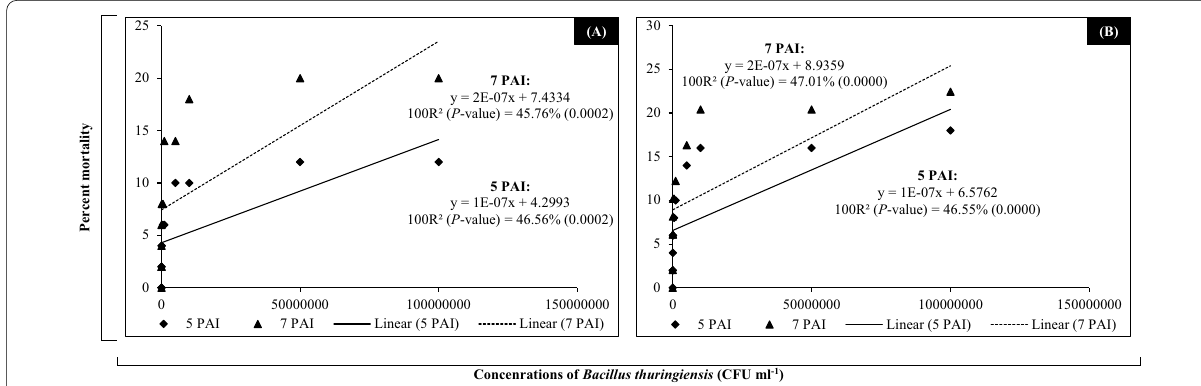
Fig. 8 Linear regression equation (Ŷ b ax), coefficient of determination (100R 2 ) and scatter diagram showing the fitted simple regression line = ± of Ŷ [percent mortality of adult male Bactrocera zonata (a) and adult female Bactrocera zonata (b) ] on X [Concentrations of Bacillus thuringiensis ] at different days post-application